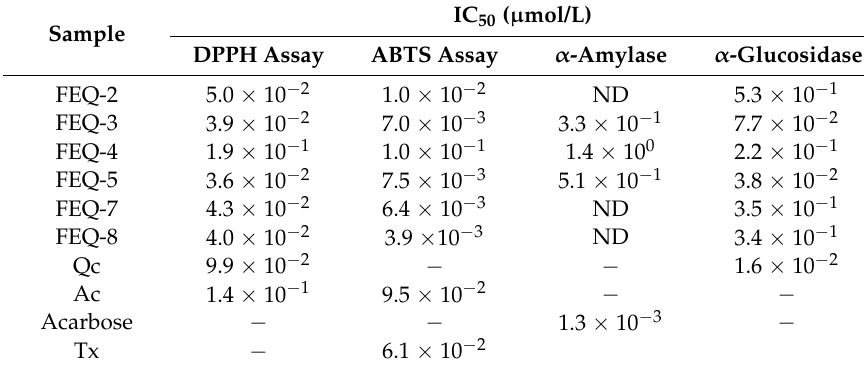
Table 3. Radical scavenging and enzyme inhibitory activity of isolated compounds from Entada spiralis stem